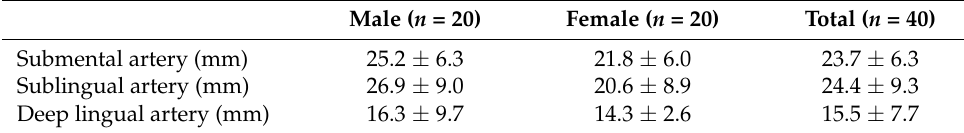
Table 4. Major axis of detectable